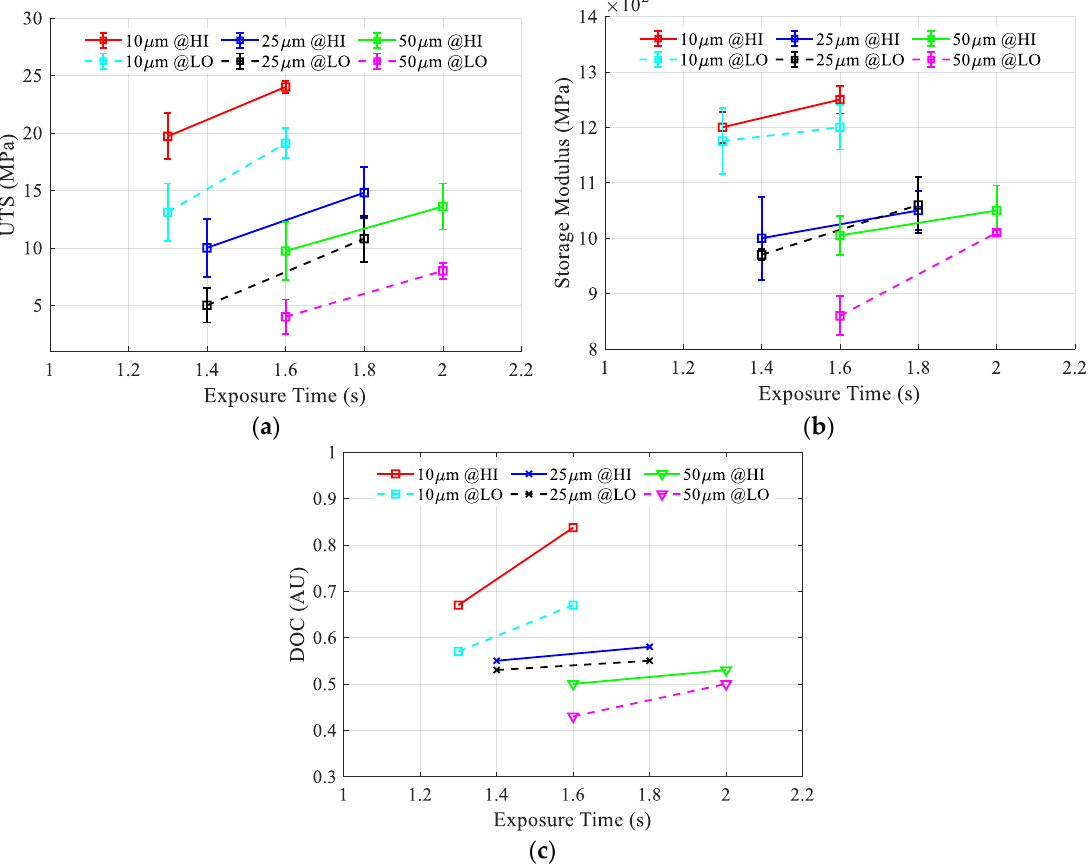
Figure 10. The effect of exposure time, layer thickness, and LED power on ( a ) Ultimate tensile